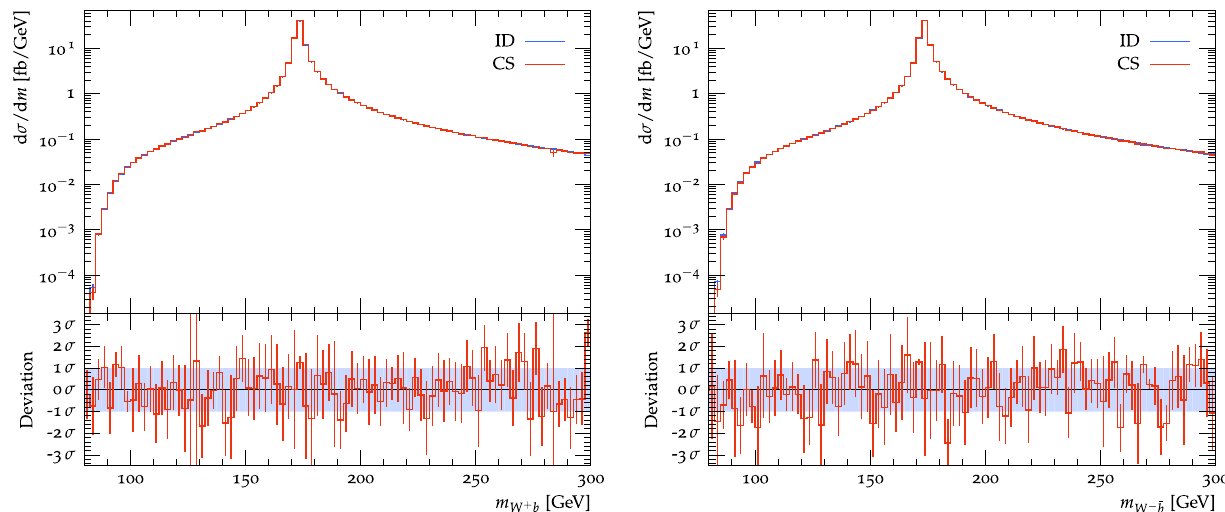
Fig. 13 Invariant mass of the (anti-)top quark reconstructed at the level of the W + W − j b j b final state from the W -boson and a b -jet with a matching flavor